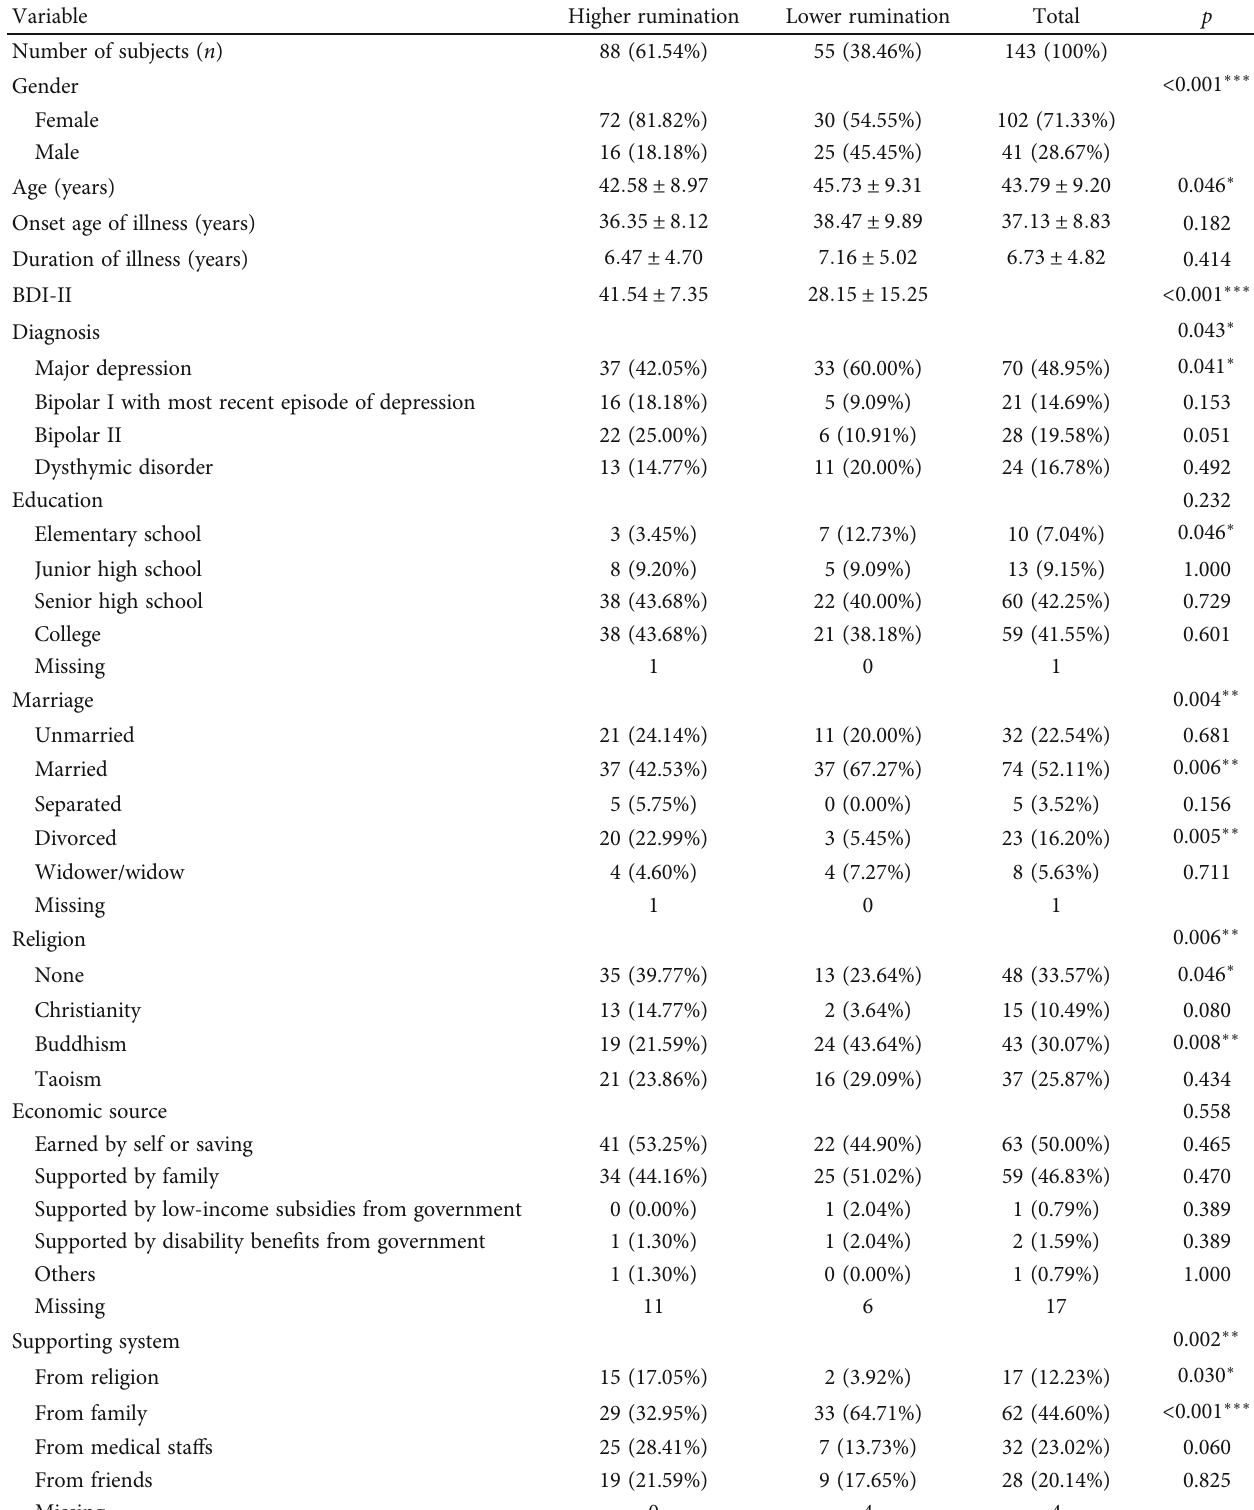
Table 1: A summary of the demographic and clinical characteristics of participants in the current study ( N = 143